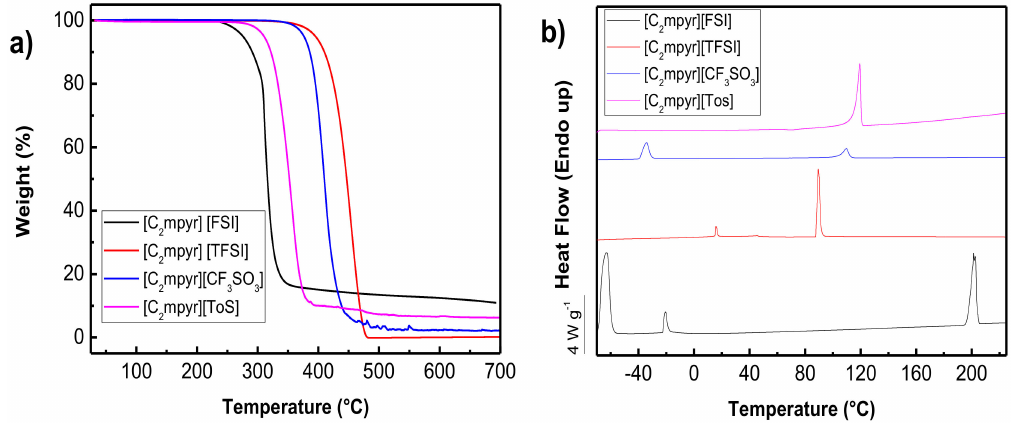
Figure 6. ( a ) TGA and ( b ) DSC curves of the organic ionic plastic crystals (OIPCs) with di ff erent